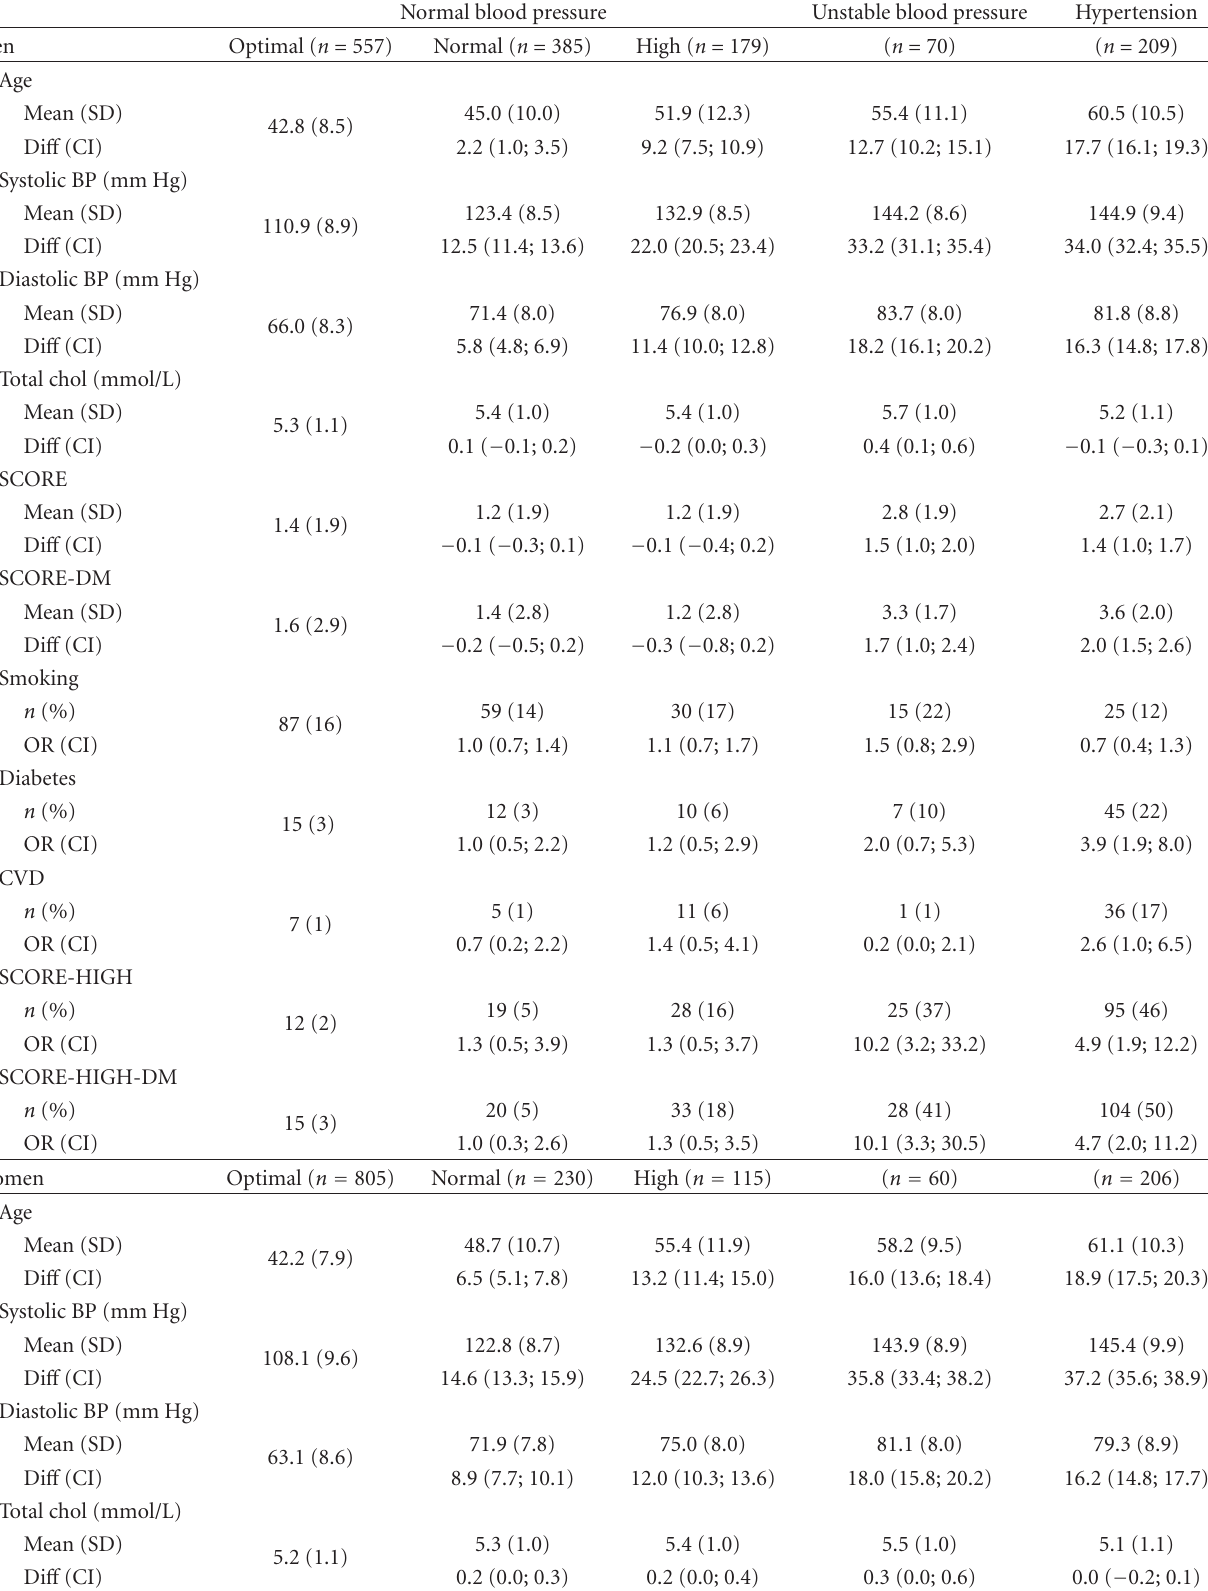
Table 2: Comparison of common cardiovascular disease risk factors between categories of hypertension in men and women using aware controlled hypertension as reference. The Vara-Sk¨ovde Cohort 2001–2005 within the Skaraborg